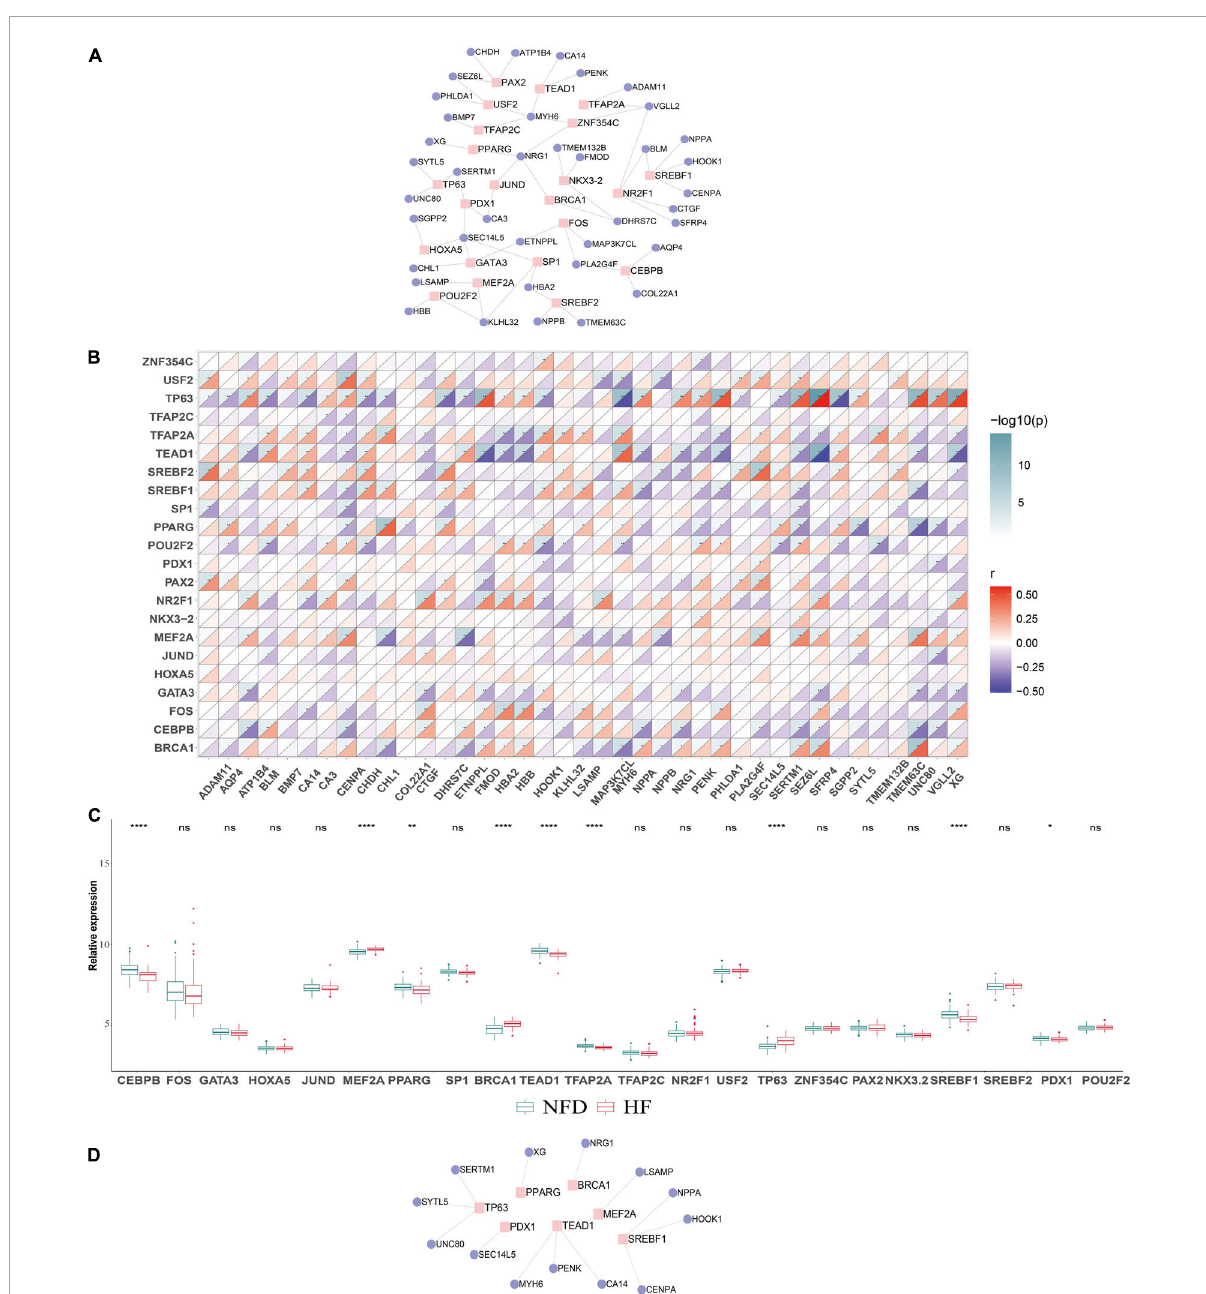
FIGURE11 Construction of the TF–DEGs regulatory network in HF. (A) TF–DEG regulatory network was established based on the top 20 upregulated and the 20 most downregulated DEGs. (B) Correlation matrix between the identified TFs and DEGs. An absolute value of correlation coefficient |r| > 0.3 and p < 0.05 indicates a statistically significant relationship. (C) Relative expression of the identified TFs in the validation microarray dataset GSE57338. ns, not significant vs. the NFD group; * p < 0.05 vs. the NFD group; ** p < 0.01 vs. the NFD group; **** p < 0.0001 vs. the NFD group. (D) Identified significant TF–DEG regulation pairs according to the criteria. TFs, transcription factors; DEGs, differentially expressed genes; HF, heart failure; NFD, non-failing